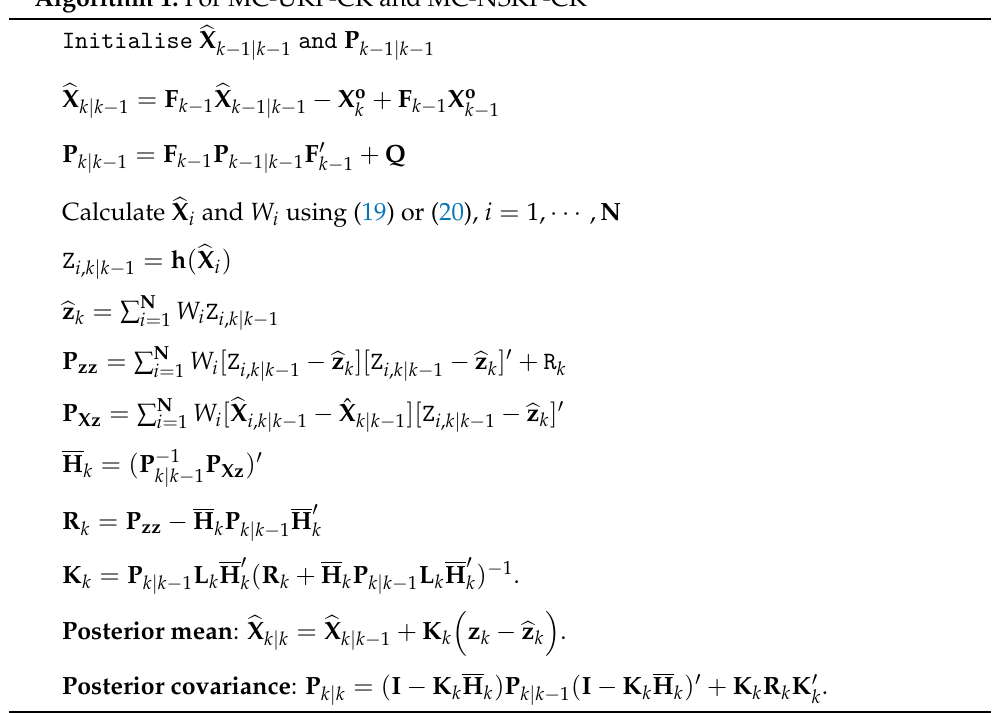
Algorithm 1: For MC-UKF-CK and